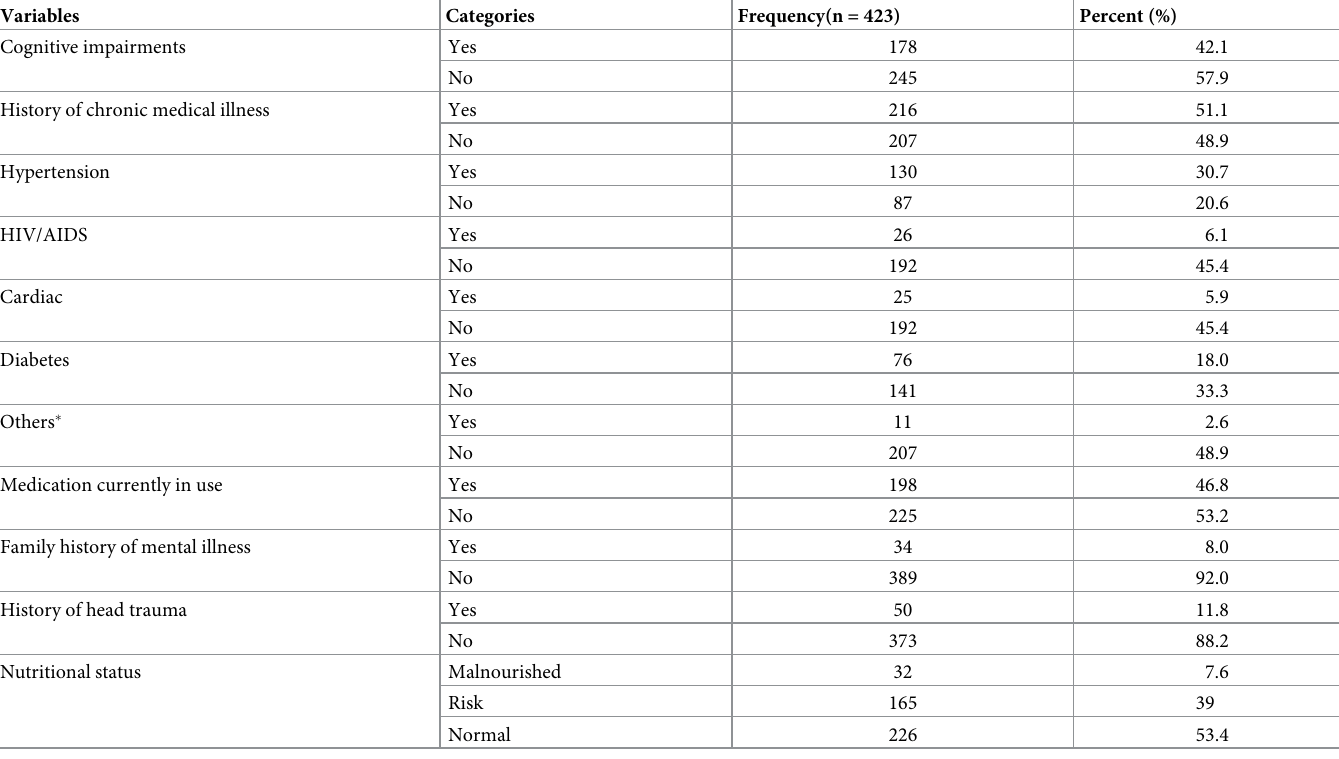
Table 2. Clinical characteristics of older adults people in Bahir Dar city administration, northwest, Ethiopia, 2020 (n =